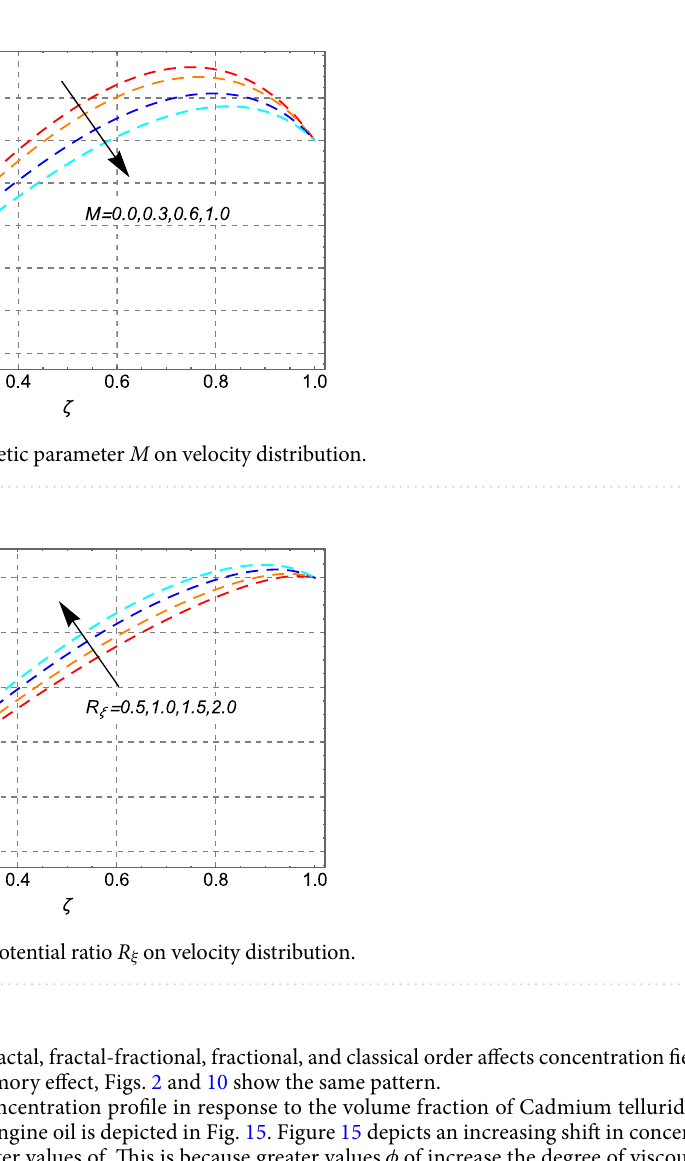
Figure 7. Impact of electro kinetic parameter k on velocity distribution.